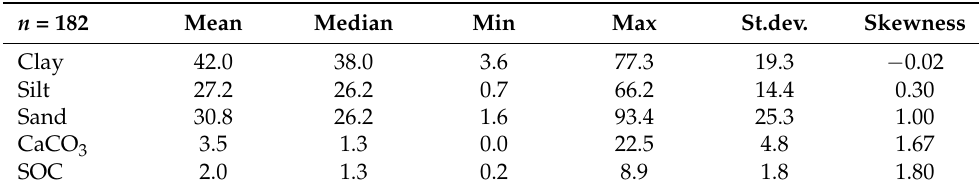
Table 1. Descriptive statistics of the analyzed parameters of the soil samples used for this study. The unit measure of all the variables was g · 100 g − 1 .